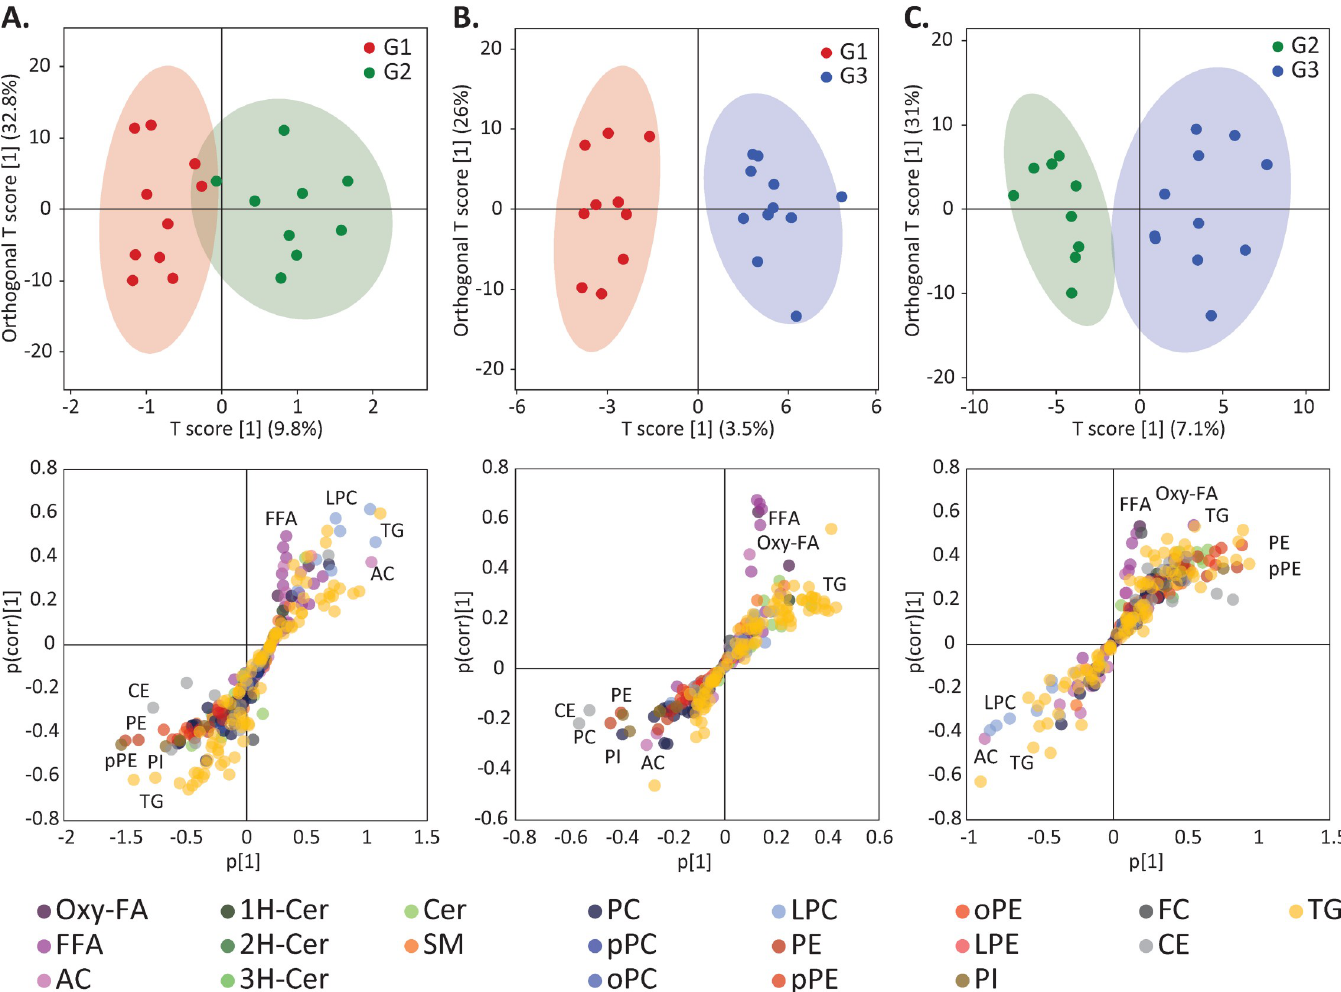
Fig 1. Multivariate analysis by orthogonal partial least square discriminant analysis (oPLSDA) revealing discriminant features in umbilical cord plasma lipidome among the groups of newborns in pairwise comparisons. The groups were composed of non-infected controls (G1), ZIKV-infected without and with microcephaly (G2 and G3, respectively). The upper and lower panels display, respectively, score and loadings plots of the oPLSDA for G1 versus G2 (A), G1 versus G3 (B) and G2 versus G3 (C). In lower panels, selected lipid classes leading to contrasting plasma lipidome composition among groups of newborns are highlighted. Abbreviations for lipid classes are depicted in Table